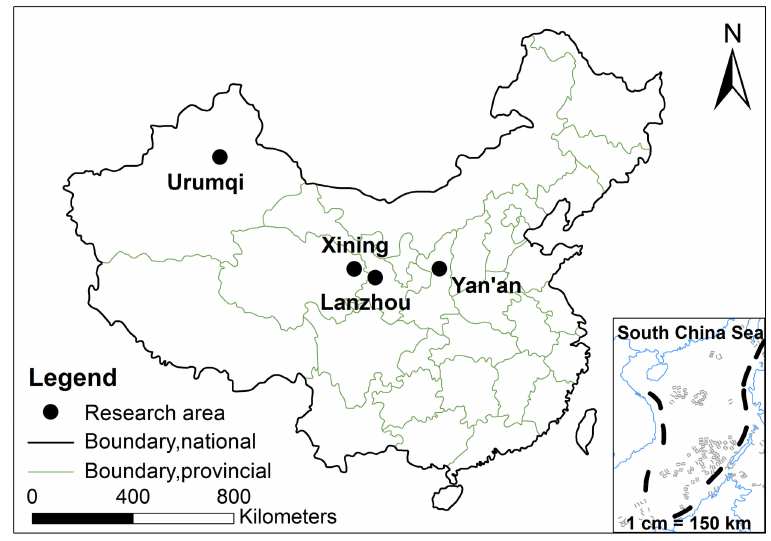
Figure 2. The research